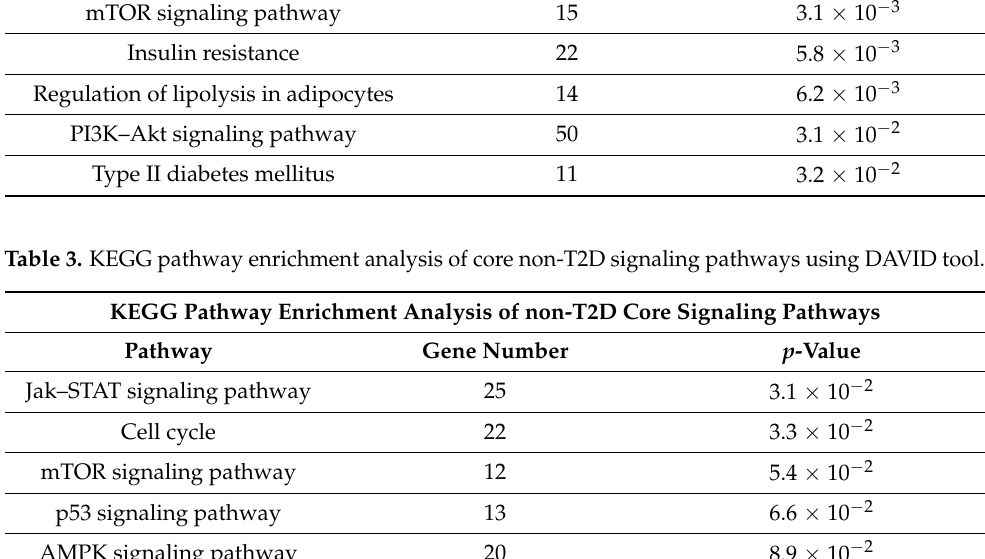
Table 2. KEGG pathway enrichment analysis of core T2D signaling pathways using DAVID tool. KEGG Pathway Enrichment Analysis of T2D Core Signaling Pathways Pathway